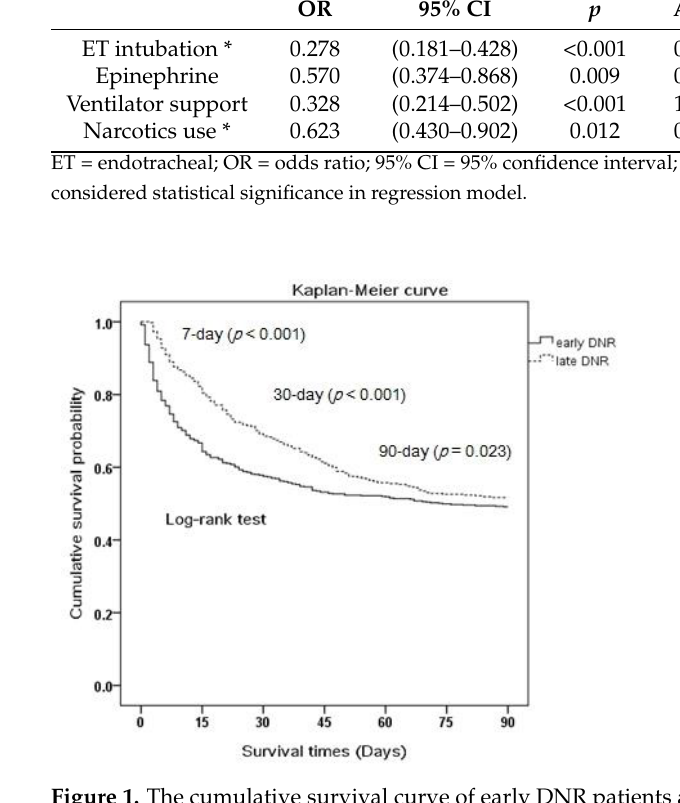
Figure 1. The cumulative survival curve of early DNR patients and late DNR